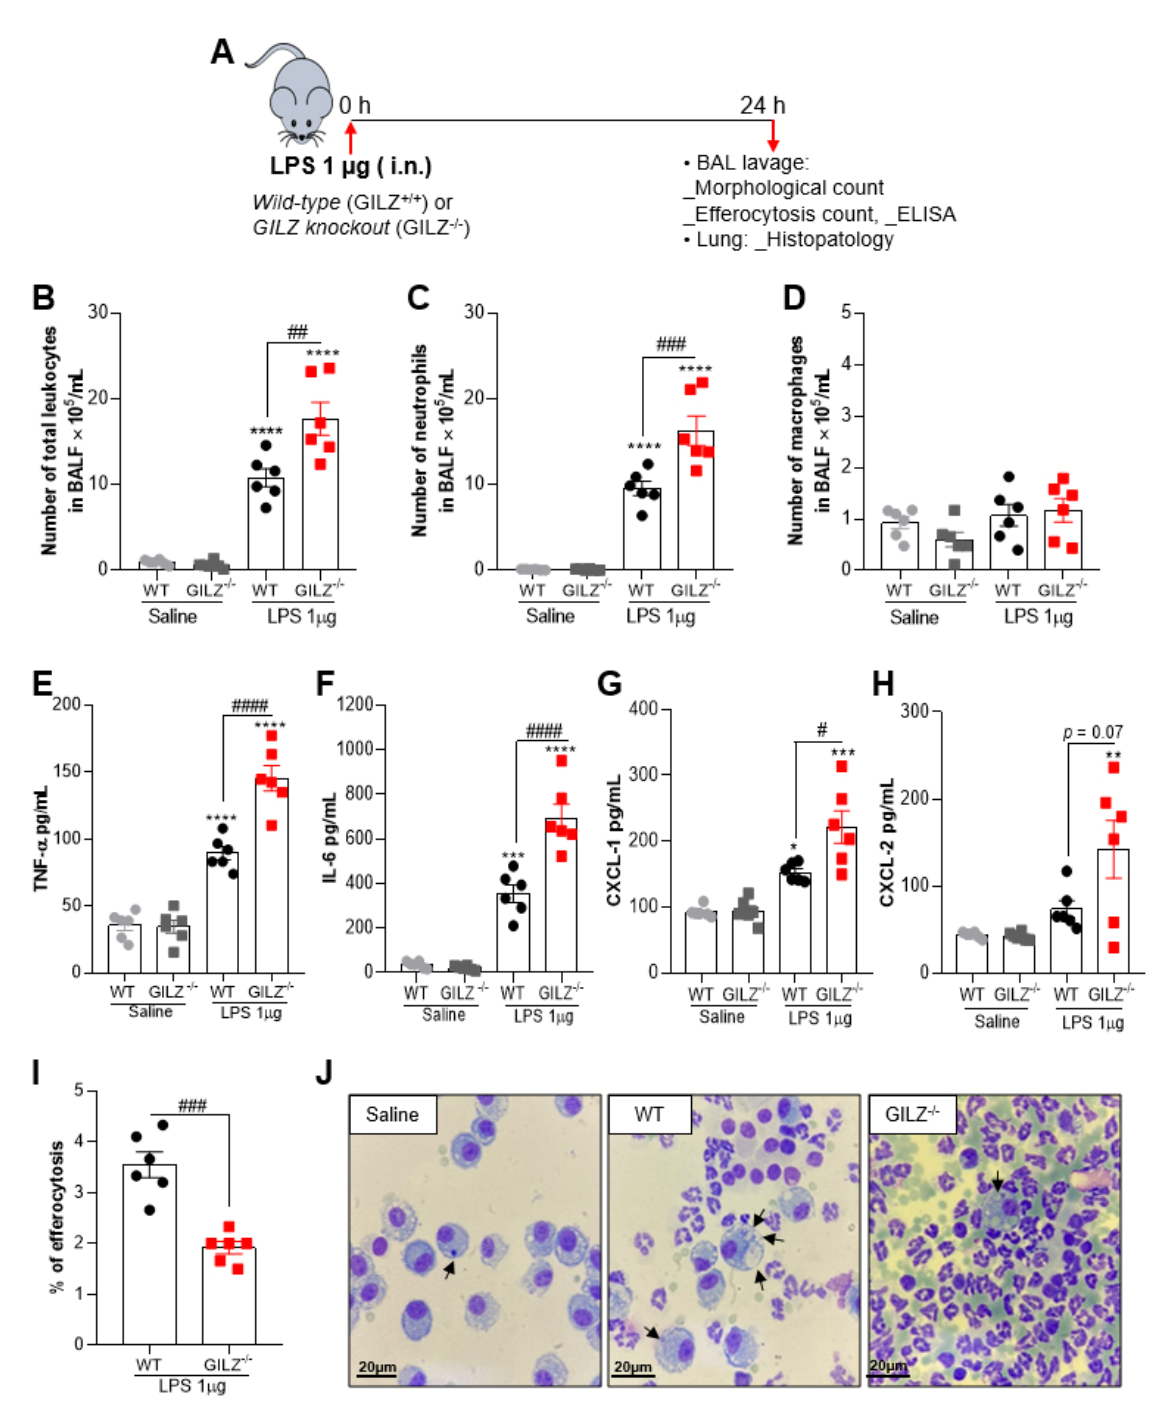
Figure 1. GILZ deficiency causes a greater inflammatory response to LPS-induced Acute Lung Injury. C57BL/6 WT or GILZ − / − mice were stimulated with LPS (1 μ g, i.n.) and euthanized 24 h later (schematic strategy in ( A )). BAL was harvested to quantify the number of total leukocytes ( B ), neutrophils ( C ) and macrophages ( D ). Levels of the cytokines TNF- α ( E ) and IL-6 ( F ) and chemokines CXCL-1 ( G ) and CXCL-2 ( H ) were measured by ELISA in BAL fluid. Graph ( I ) shows the percentage of efferocytosis by morphological counting of cytospin slides stained with May- Grunwald-Giemsa. In ( J ), arrows indicate apoptotic neutrophils inside macrophages. Magnification 100×. Data are mean ± SEM of N = 6 animals per group. * p < 0.05, ** p < 0.01, *** p < 0.001 or **** p < 0.0001 when compared to the saline group; or as indicated: # p < 0.05, ## p < 0.01 ### p < 0.001 or #### p < 0.0001 when comparing LPS-challenged GILZ − / − to WT mice, by 2-way ANOVA.